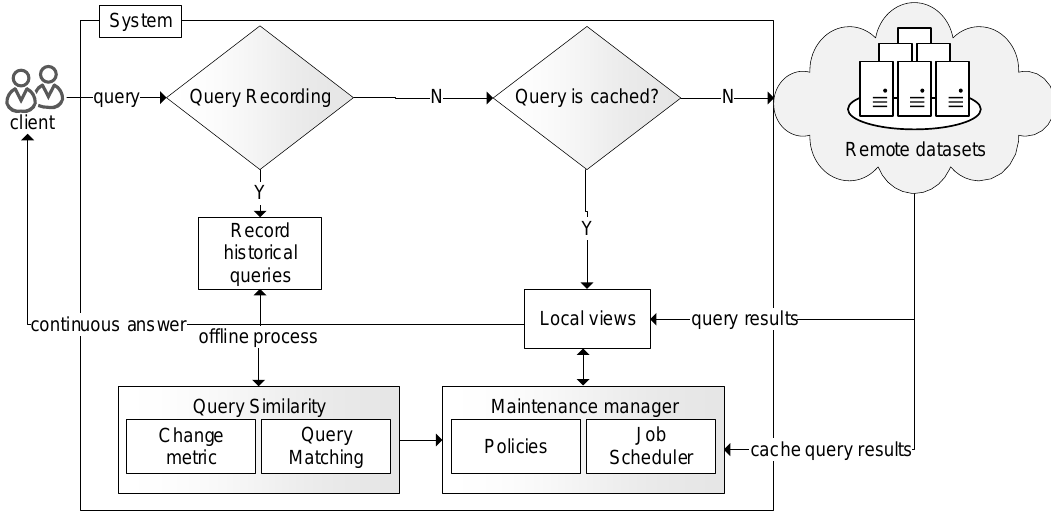
Figure 2. Overall architecture of the proposed